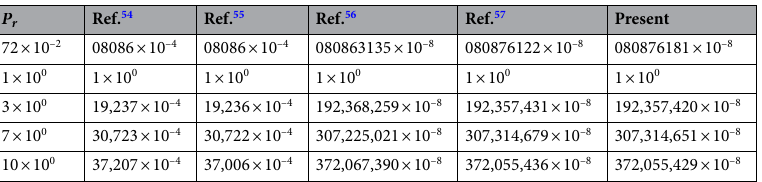
Table 4. Comparing of − θ ′ ( 0 ) values with P r , when φ = 0 , φ hnf = 0 , E L = 0 , (cid:31) L = 0 , N L = 0 , S = 0 and G L = 0